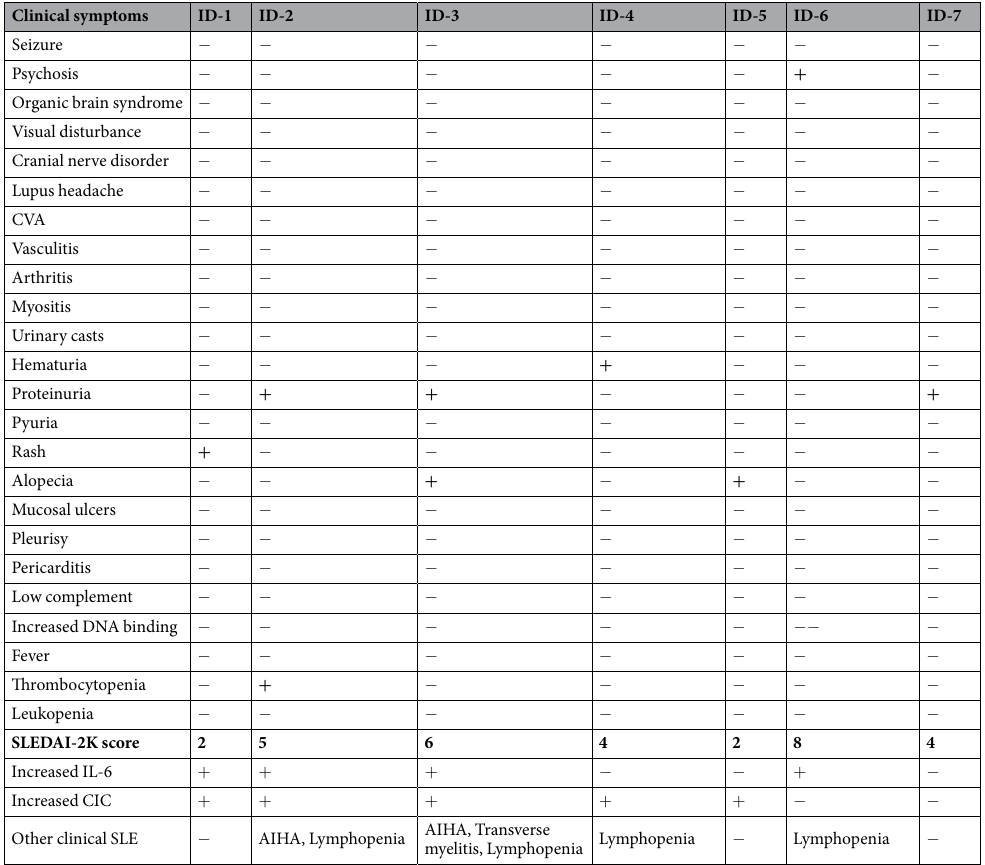
Table 6. Clinical features and SLEDAI-2K of clinically active SLE patients with normal complement and anti-